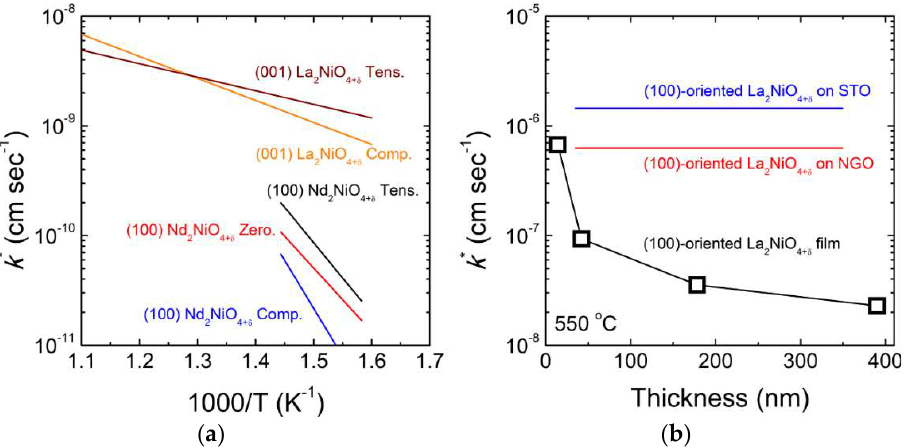
Figure 7. Arrhenius plots of surface exchange coefficients ( k * ) for A 2 NiO 4+δ (A = La and Nd): ( a ) Tensile (Tens.) and compressive (Comp.) strained (001)-oriented La 2 NiO 4+δ films [61] and tensile, zero, and compressive strained (100)-oriented Nd 2 NiO 4+ δ thin films [135]; ( b ) (001)- and (100)-oriented La 2 NiO 4+δ [61],[63] thin films with various thickness and substrates.